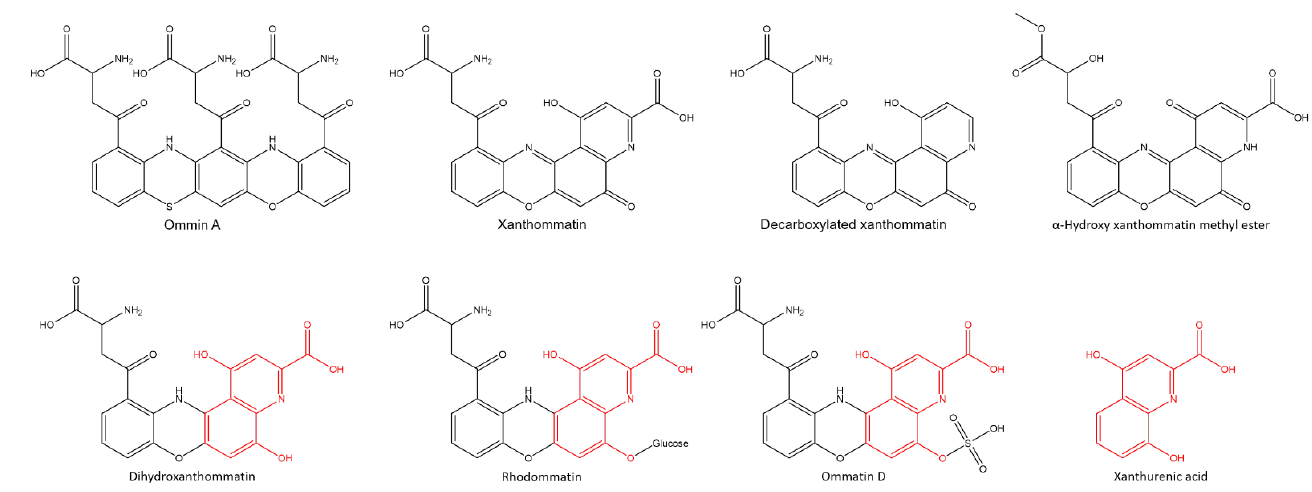
Figure 4. Structure of ommin A, some known ommatins and xanthurenic acid.